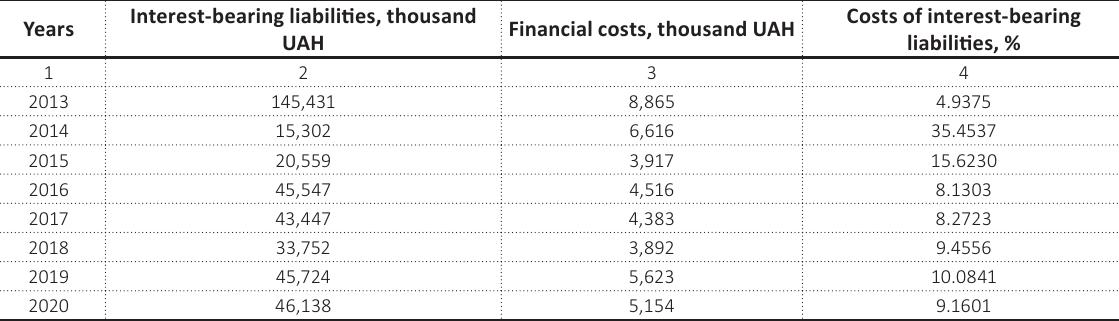
Source: Calculated by the